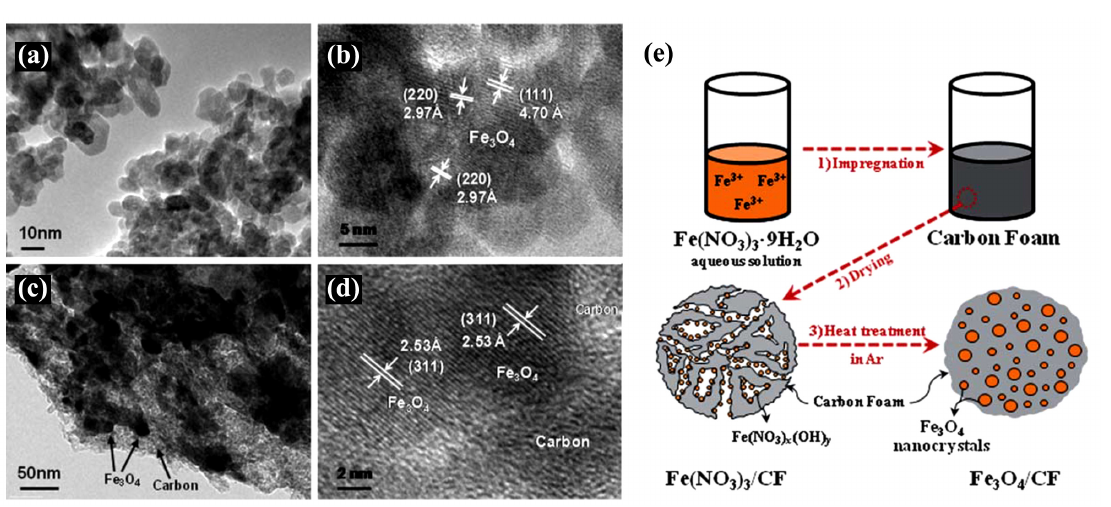
O NPs synthesized by: ( a , b ) the hydrothermal 3 4 O NPs on the CF composite; and ( e ) schematic 3 4 O nanocrystals in the confined pores of carbon 3 4